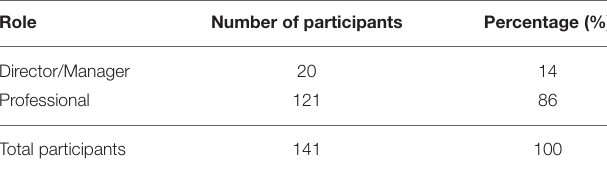
TABLE 4 | Participants level of seniority within their